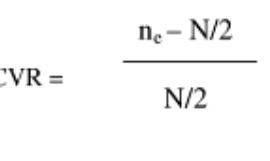
Minimum values of the content validity ratio for significance at p<0.5